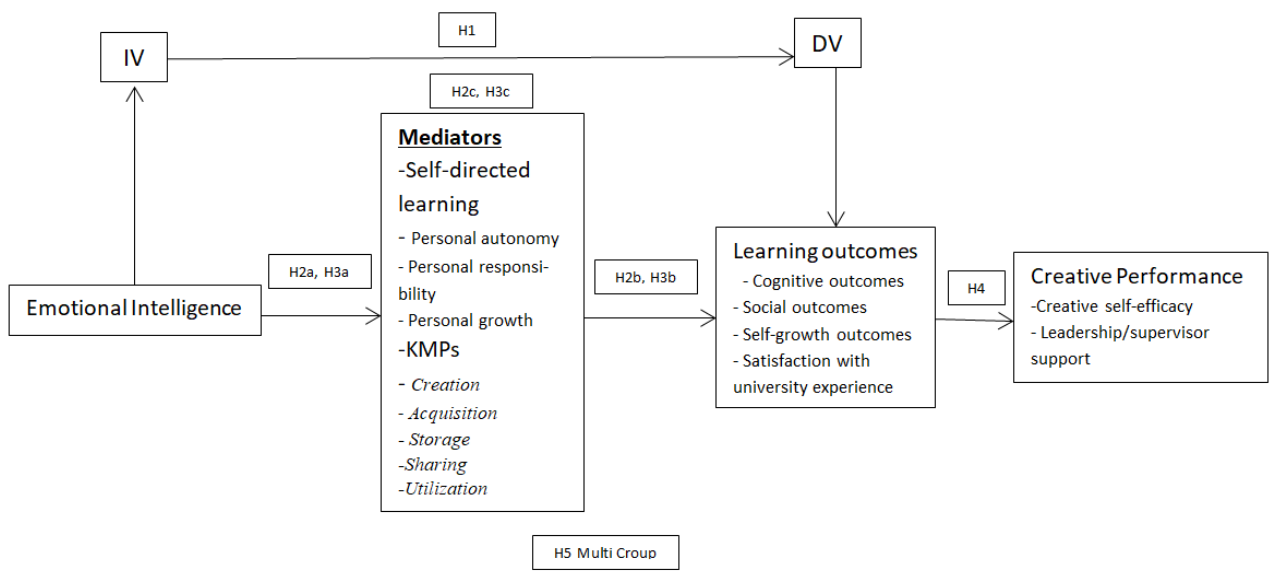
Figure 1. Conceptual Framework.